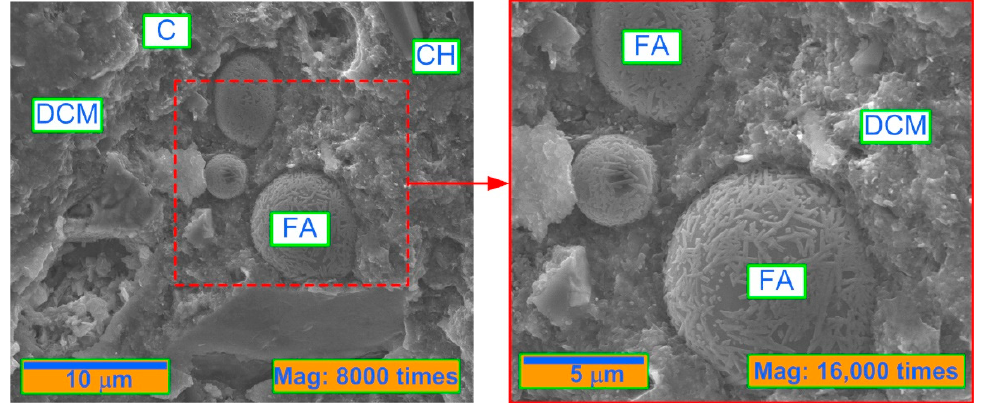
Figure 8. SEM microimages of analyzed T2 concrete; descriptions in the text.